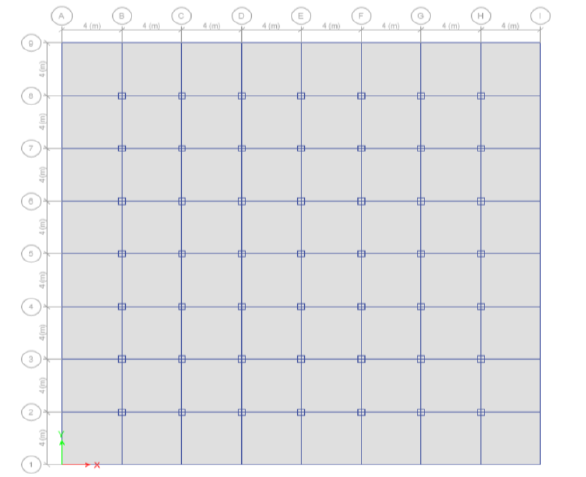
Fig 1 . Plan of the building models.